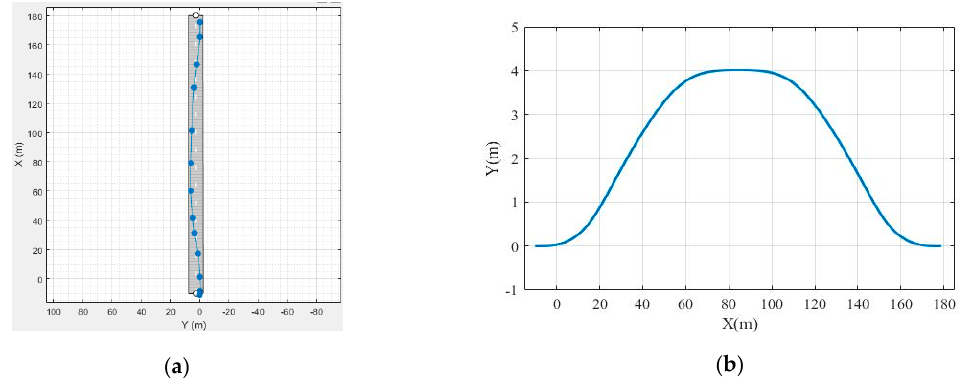
Figure 5. Double lane changing control simulation: ( a ) driving scenario; and ( b ) reference trajectory.